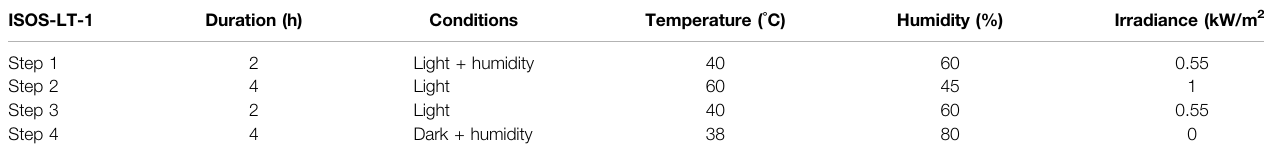
TABLE 2 | Cycle of weather simulation using the Q-Sun system to characterize the degradation process, complying with the ISOS-LT-1 protocol.